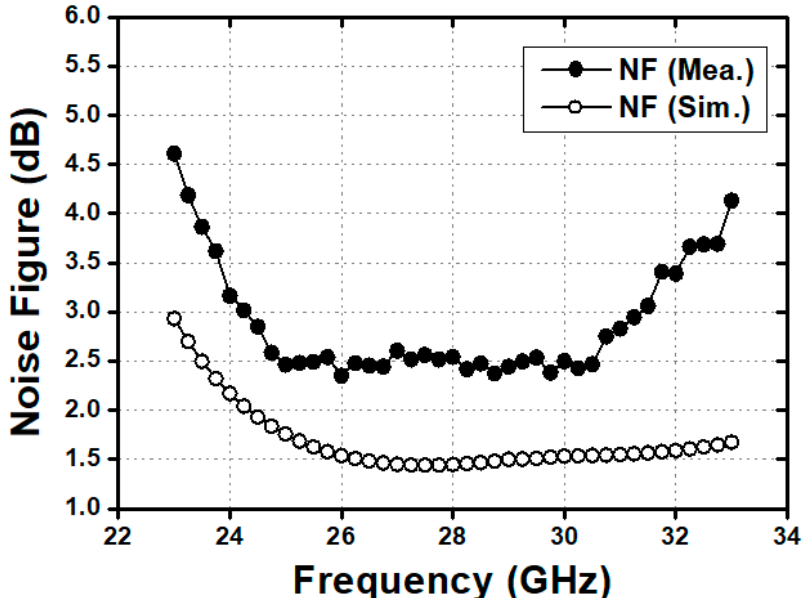
Figure 12. Measured and simulated NFs of the LNA.